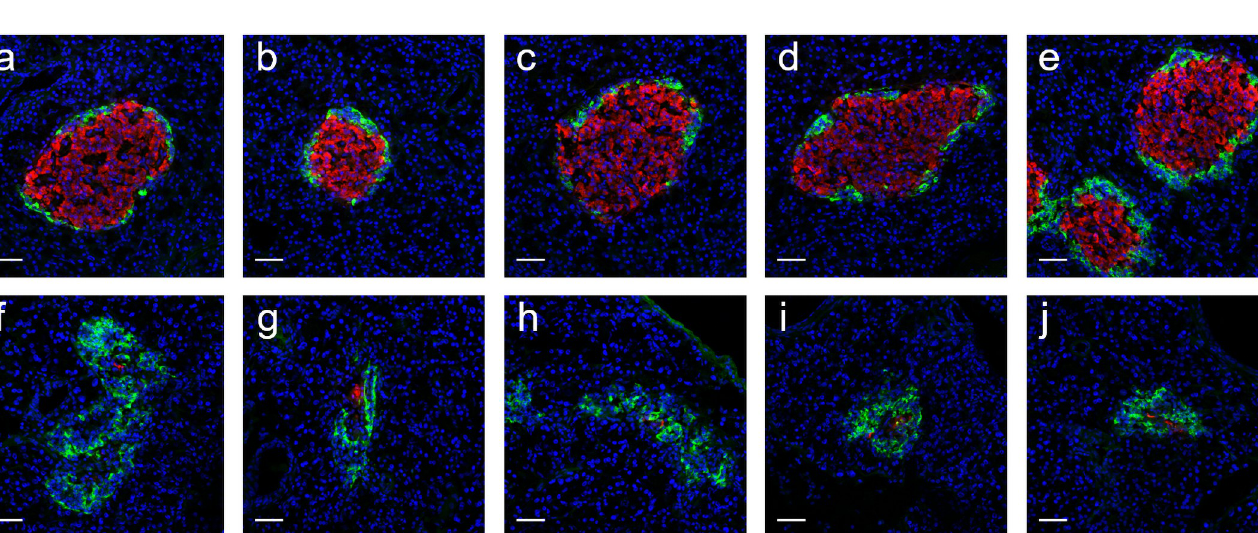
(Table 2). We have also measured HbA1c levels of healthy and diabetic rats as shown in Table 3. The diabetic rats showed significantly higher HbA1c levels than healthy rats.